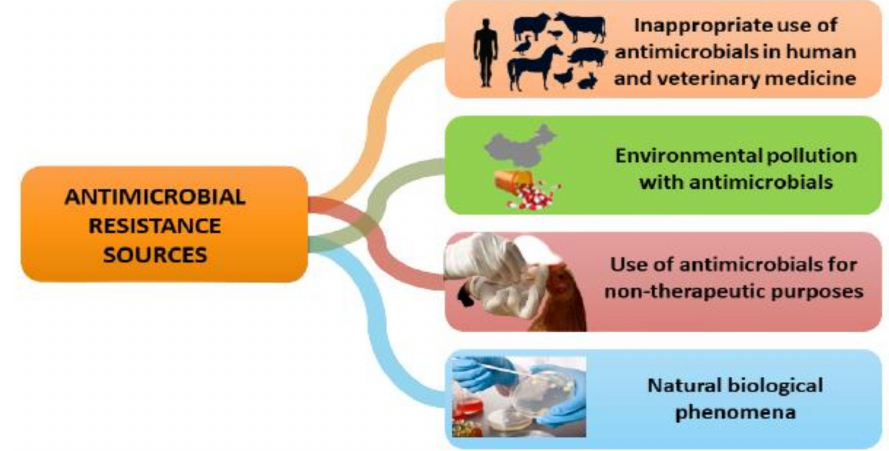
Figure 2. Main sources of antimicrobial